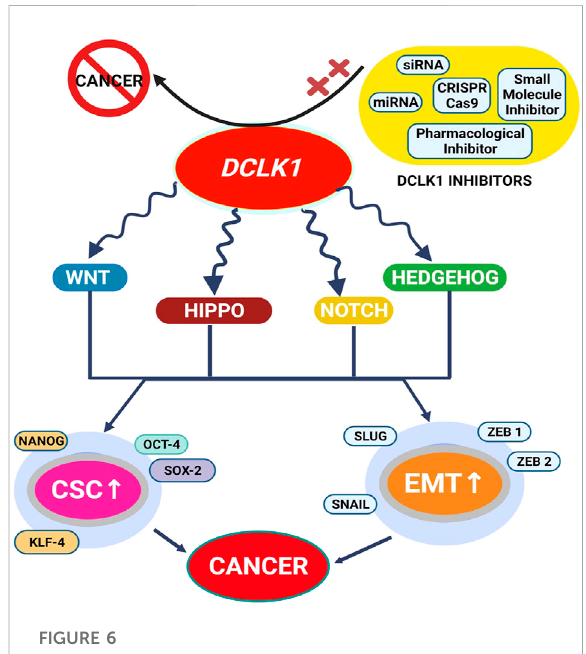
FIGURE 6 DCLK1 is identi fi ed as an understudied kinase and is found to be upregulated in most cancers. Its upregulation is reported to be associated with altered signaling pathways and gene functions. Upregulations of CSC and EMT factors are the prominent DCLK1 expression regulator and are found to be elevated under most cancer conditions. With such aberration and therapy resistance, the implementation of small molecule DCLK1 inhibitors and DCLK1 targets to downregulate DCLK1 has led to the suppression of DCLK1 overexpression, thereby inhibiting cancer